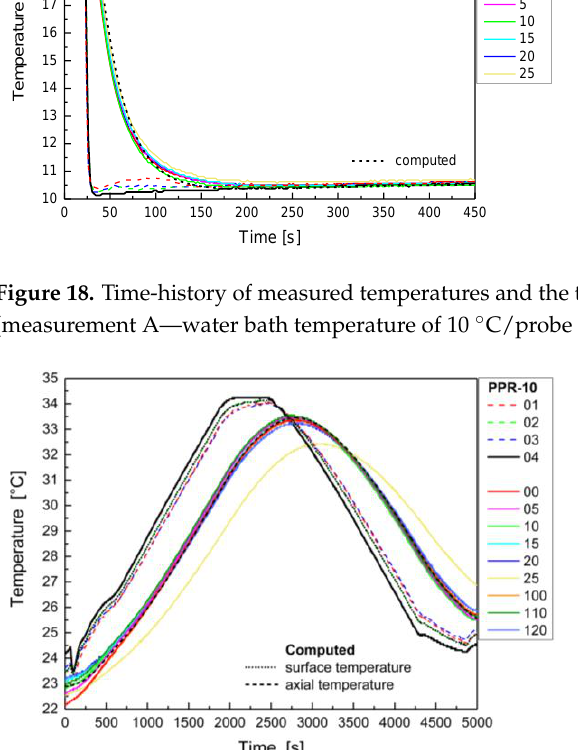
Figure 18. Time-history of measured temperatures and the temperatures computed in the probe axis (measurement A — water bath temperature of 10 °C/probe 2).